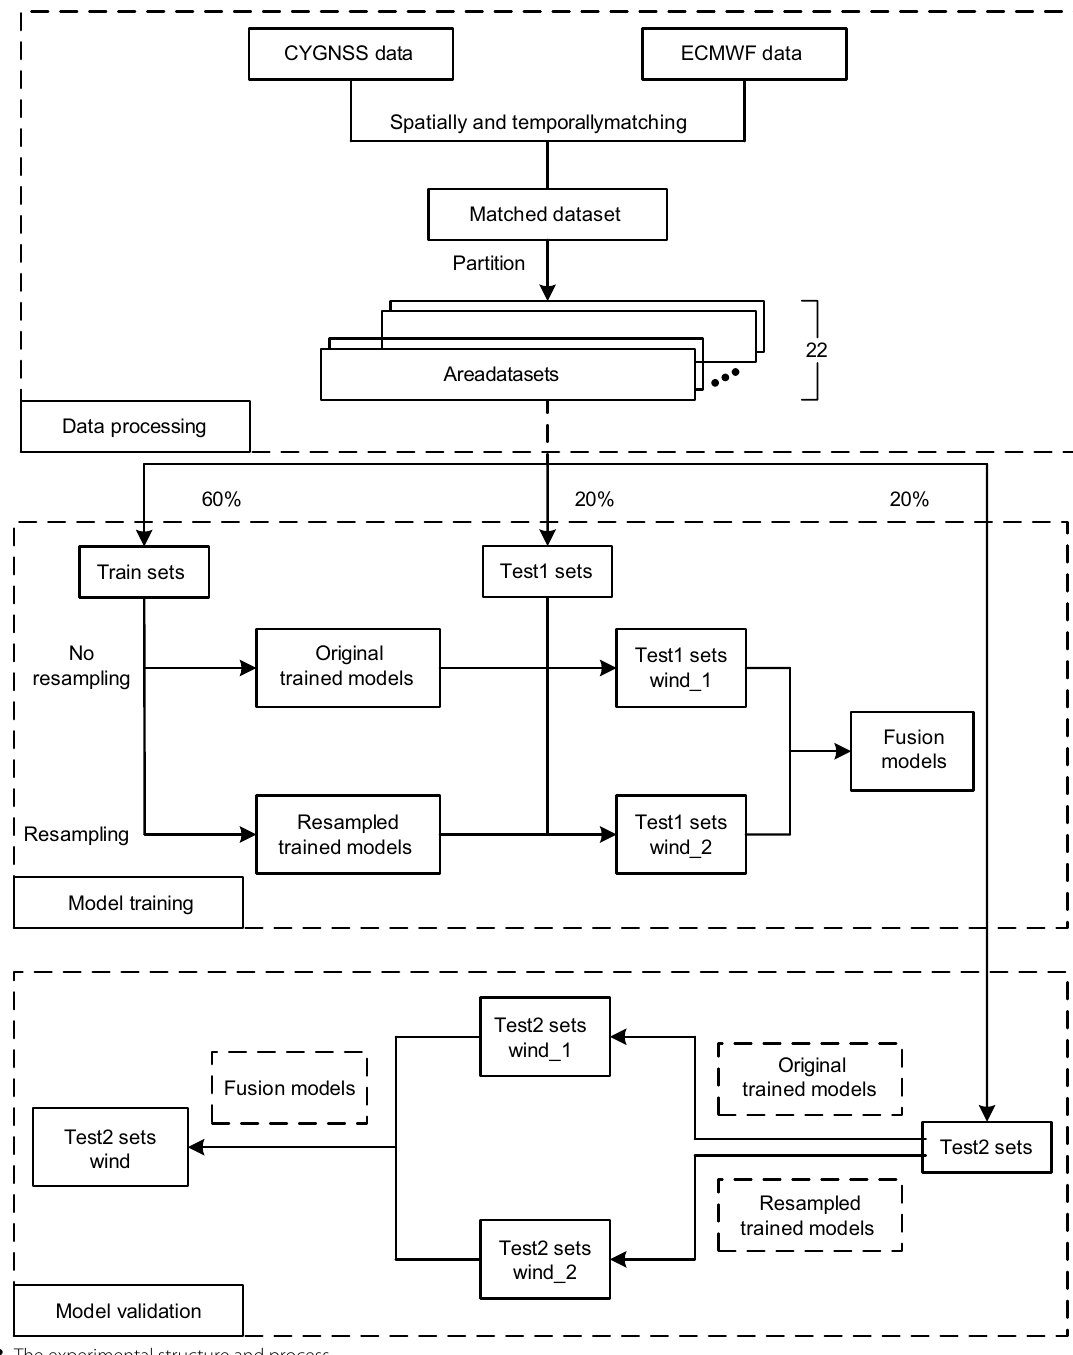
Fig. 8 The experimental structure and